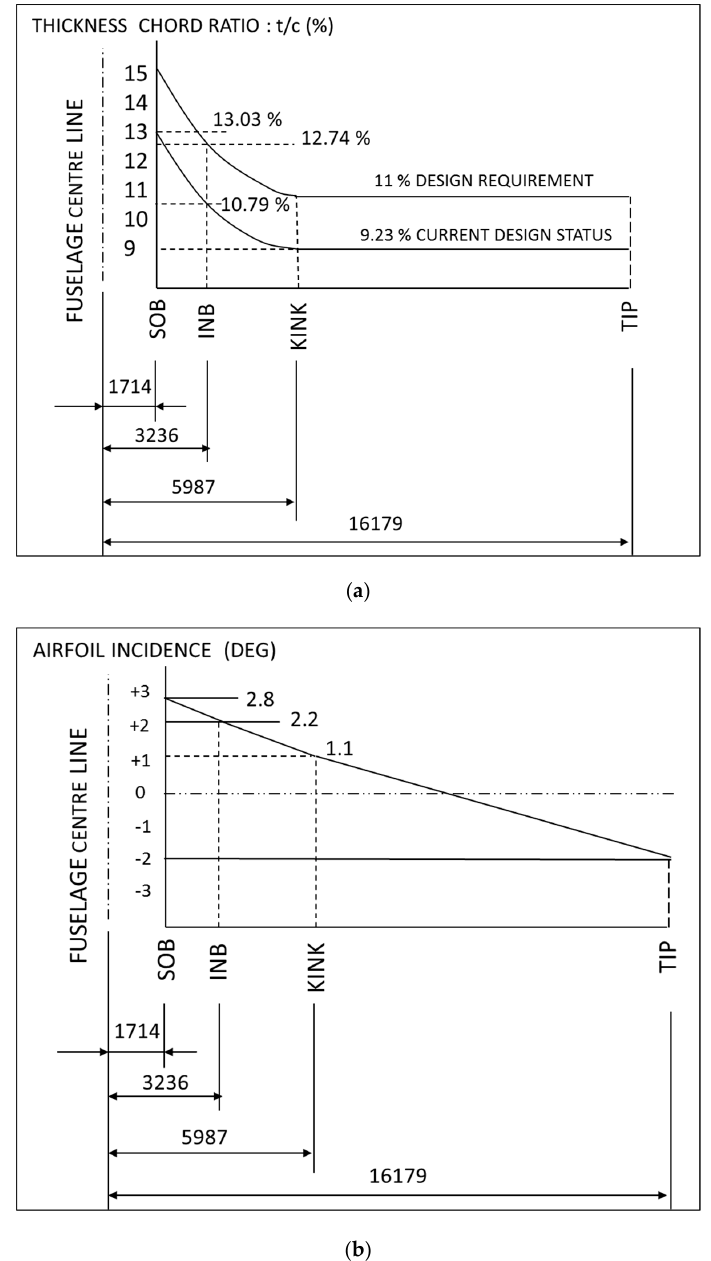
Figure 3. Wing of Advanced Technology Regional Aircraft (W-ATRA) ( a ) thickness distribution ( b ) twist distribution [19]. All the distances are in mm.